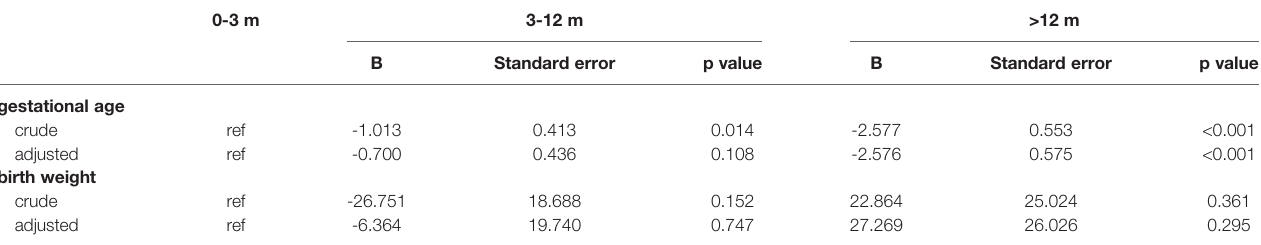
TABLE 4 | Multivariable linear regression of gestational age and birth